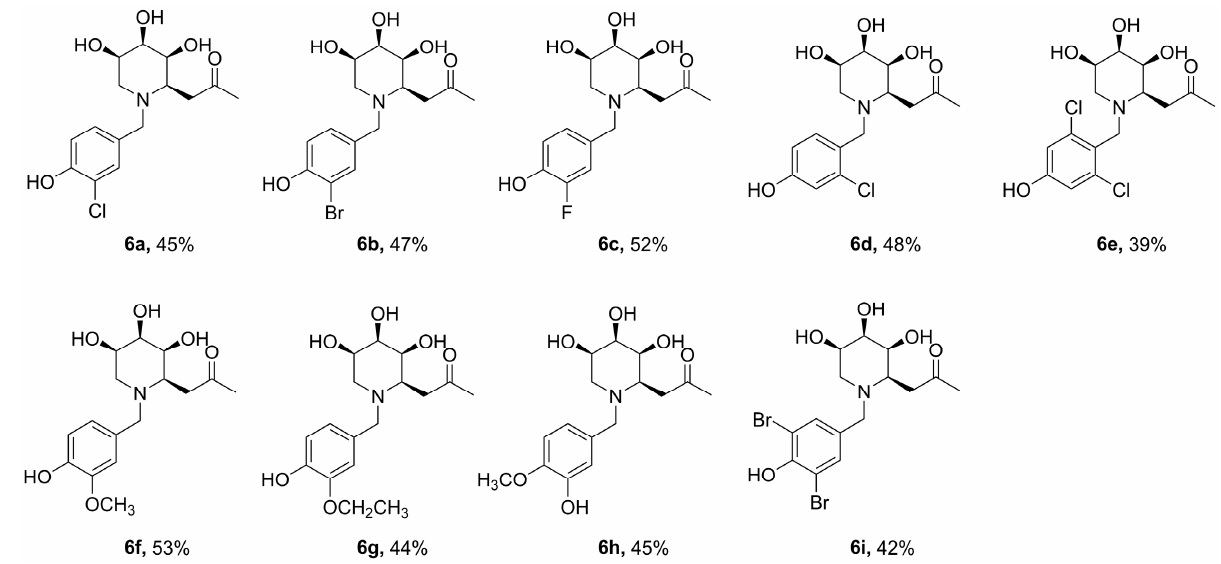
Figure 4. Synthesized N -substituted iminosugar C -glycosides ( 6a – 6i ). Table 2. The IC 50 value of the compounds against α -glucosidase from yeast. Table 2. The IC 50 value of the compounds against α ‐ glucosidase from yeast. Compound IC 50 ( µ